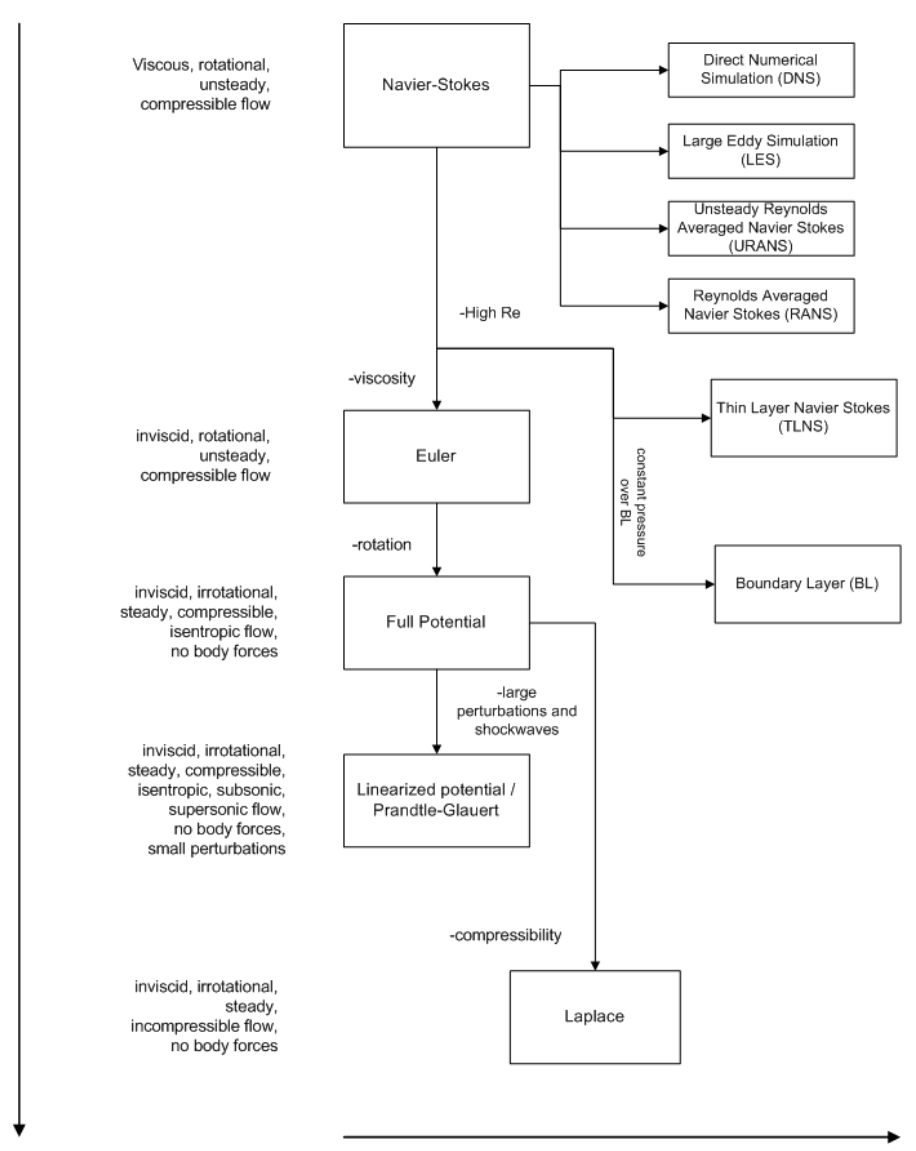
Figure 1. The evolution of aerodynamic flow models